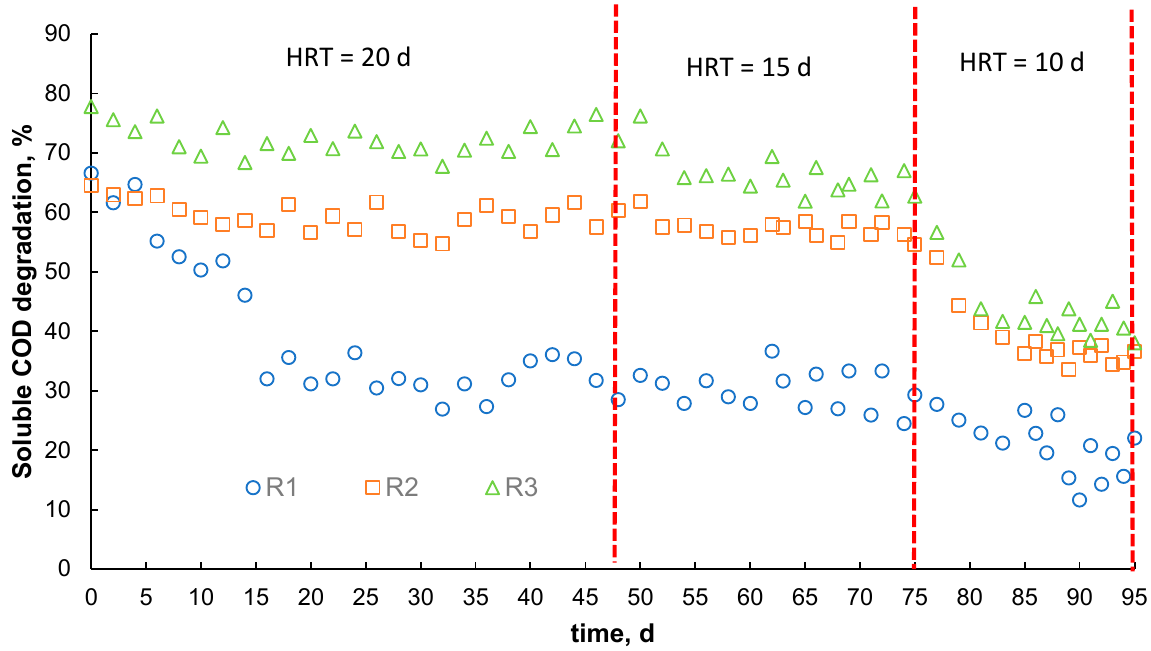
Figure 3. Profiles on time of sCOD degradation for the R1 (control), R2 (thermal pre-treatment) and R3 (micro-aerobic pre-treatment) digesters at 20, 15, and 10 days of HRT.